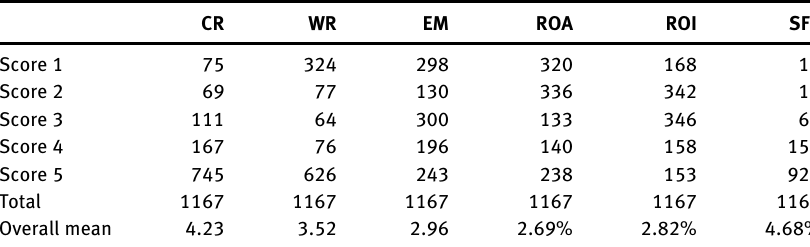
Table  : Score distribution within the SC sample, year  .